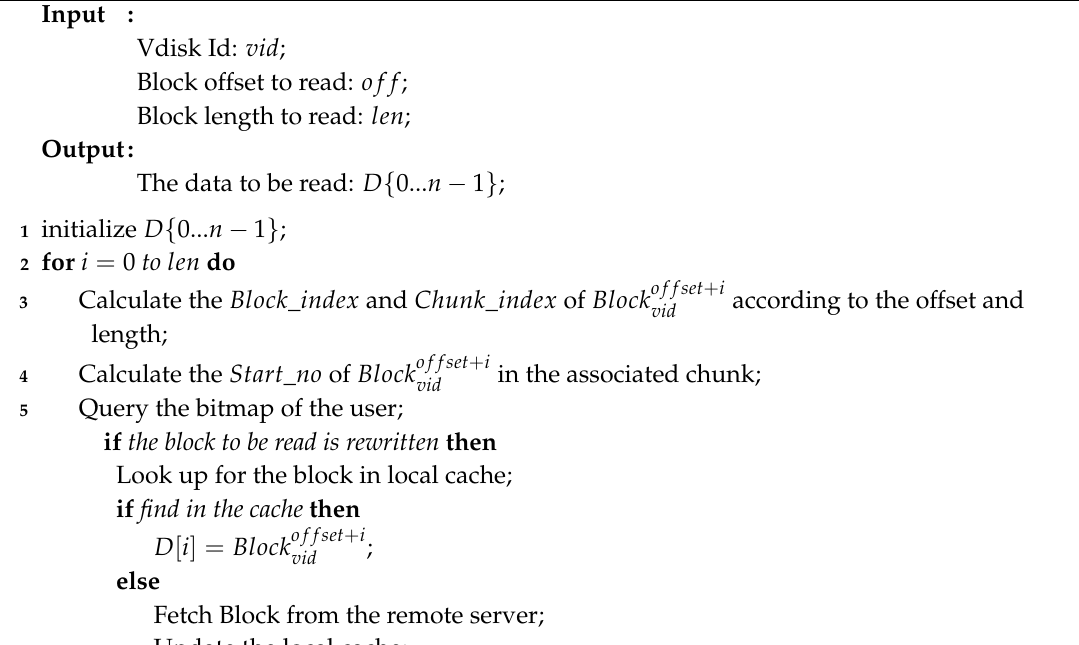
Algorithm 1: Algorithm for reading blocks of Vdisk at aggregation